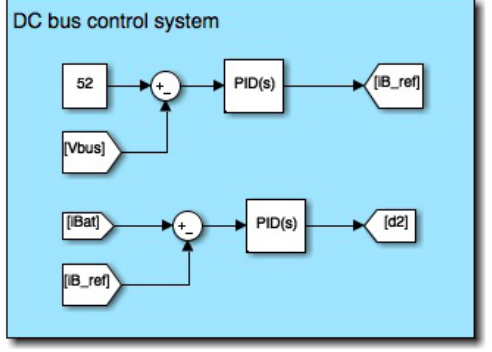
Figure 24. DC bus control system simulation block